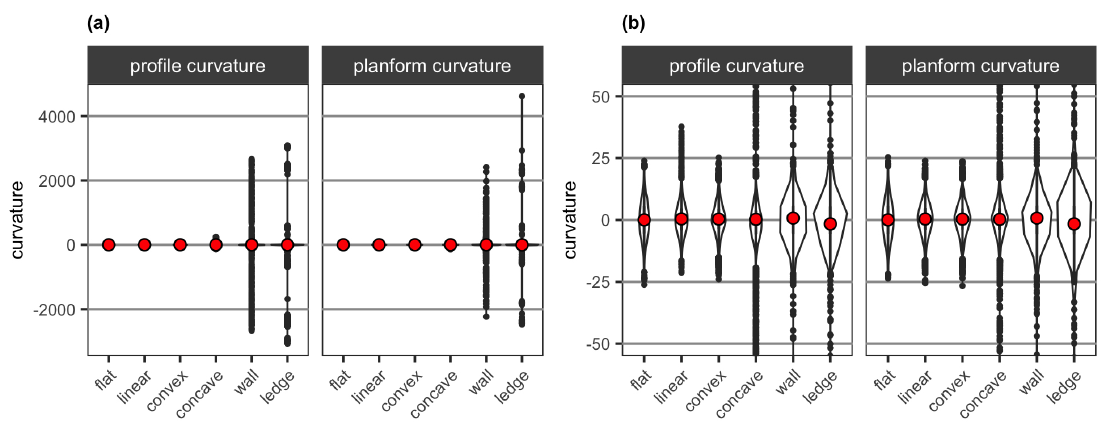
Figure 9. Violin plots for profile curvature and planform curvature extracted from the DEMs of the six simulated surface structures ( a ) for the entire data range and ( b ) for the range between − 50 and 50. The mean value of curvature for each surface structure is shown as red